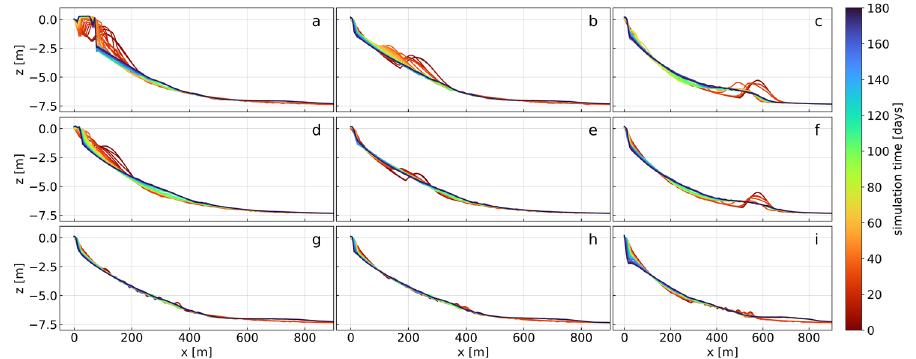
Figure 17. Central profile evolution for VB, where color indicates elapsed simulation time. ( a – c ) LB at 3 m, 5 m, and 7 m depths, respectively. ( d – f ) UB at 3 m, 5 m, and 7 m depths, respectively. ( g – i ) DM at 3 m, 5 m, and 7 m depths, respectively.